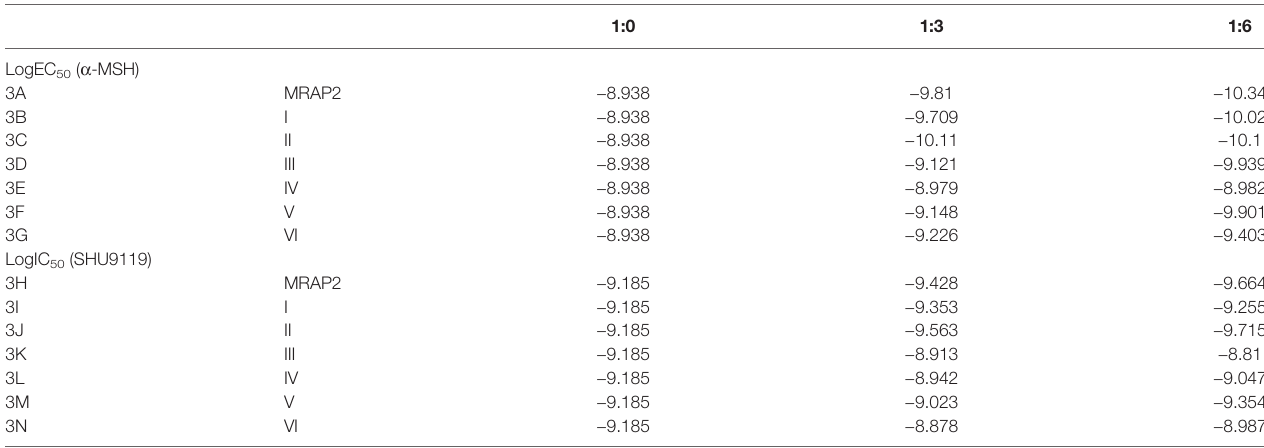
TABLE 2 | Statistical analysis of Figure 3